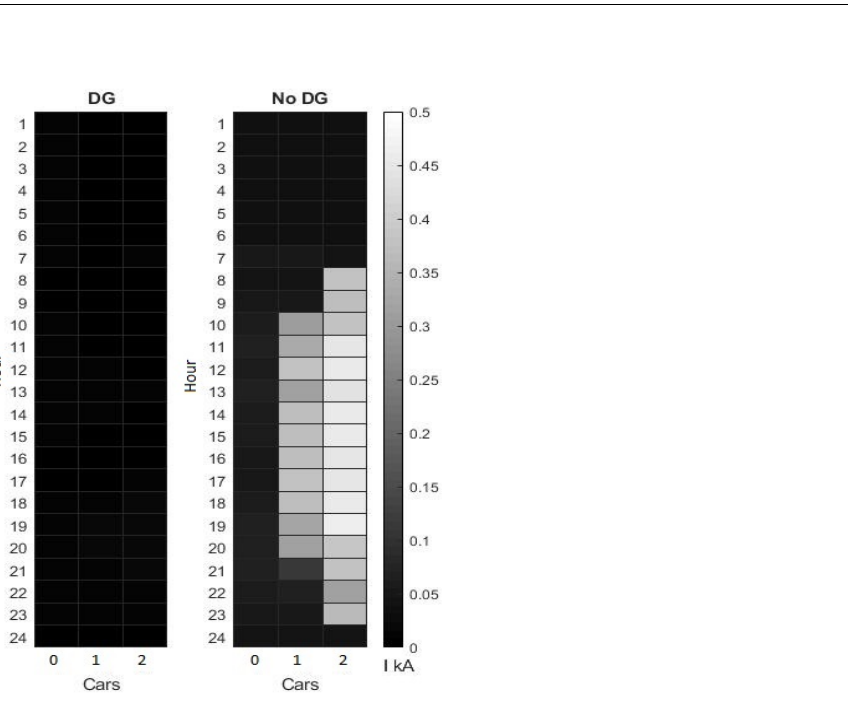
Figure 15. Total current requirements for the entire network versus the number of allowed cars across every two houses.